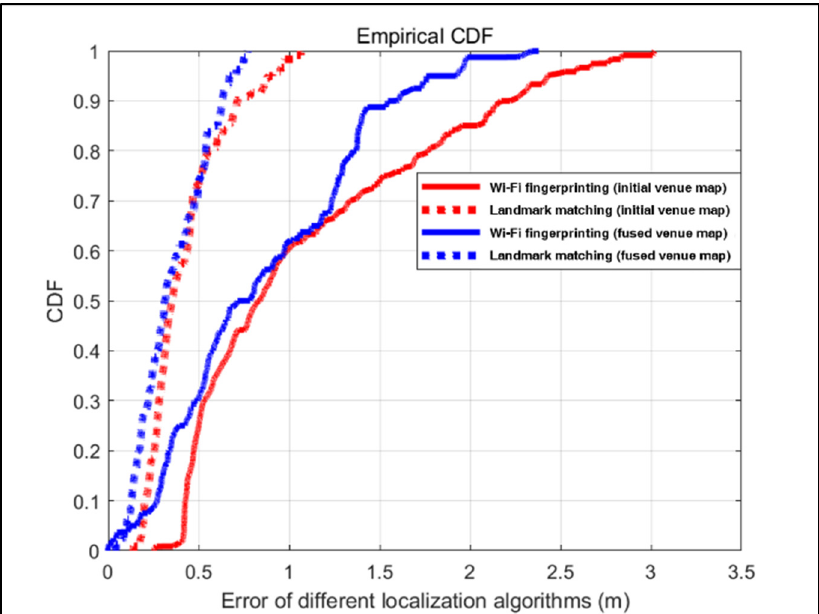
Figure 11. CDF of the location estimation error for the office building scene.